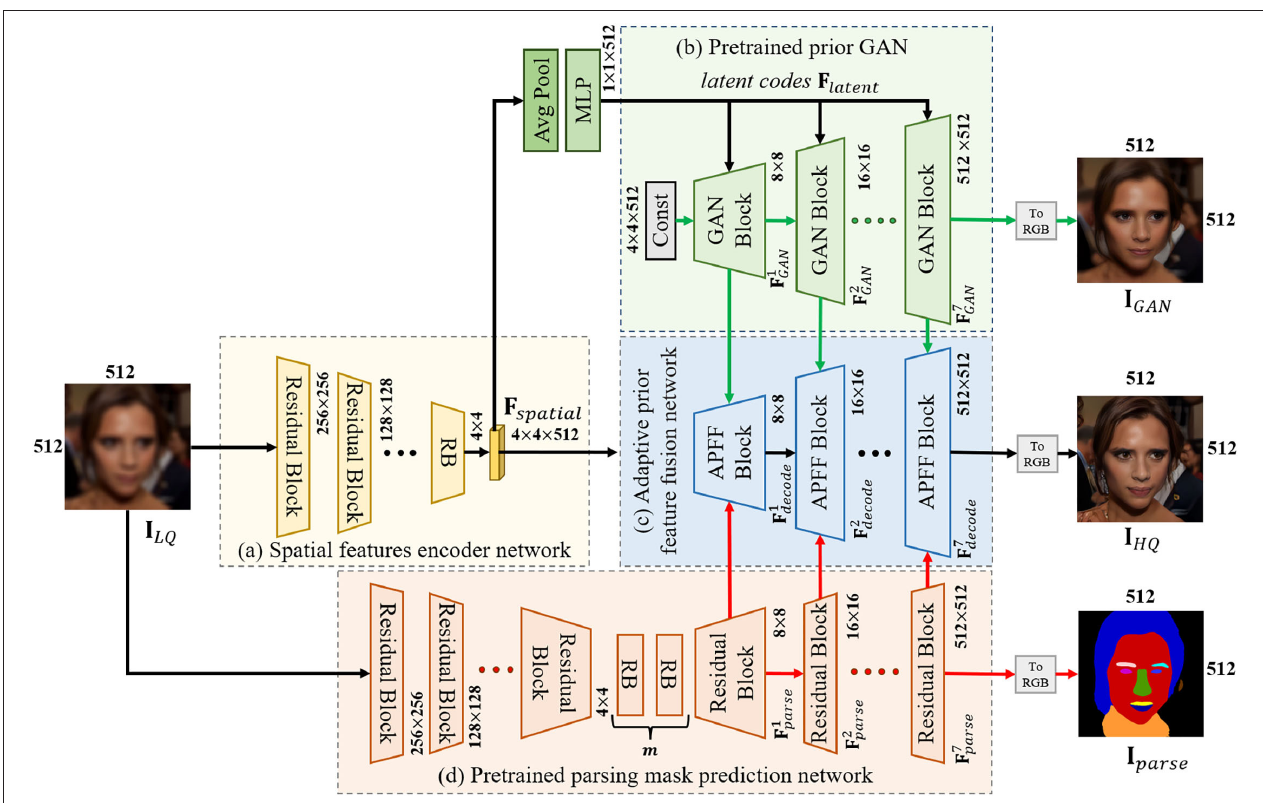
FIGURE 2 | The detailed architecture of the proposed network. (a) Spatial feature encoder network. (b) Pretrained prior GAn. (c) Adaptive prior feature fusion network. (d) Pretrained parsing mask prediction network.